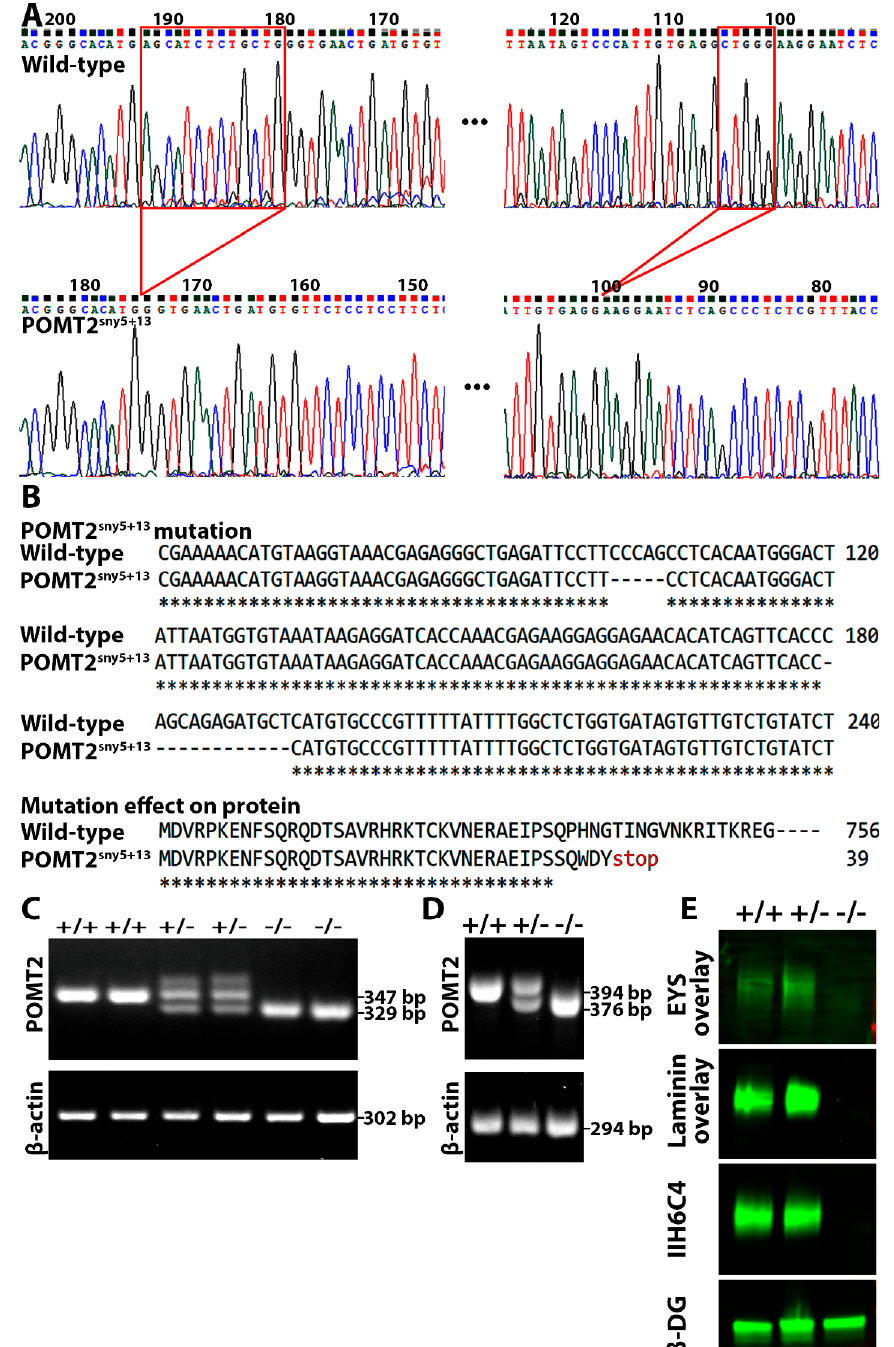
Figure 1. Deletion of pomt2 in zebrafish ablated matriglycan and caused loss of EYS binding. pomt2 mutant zebrafish were generated by CRISPR. Crossing of heterozygous mutant zebrafish generated homozygous mutant fish. Skeletal muscle lysates were used for IIH6C4 immunoblotting and EYS overlay assays. ( A ) Sequencing chromatogram of wild-type and pomt2 sny5+13 PCR product. The two small deletions in exon 2 are bracketed with red marks. ( B ) Alignment of part of exon 2 sequences showing the two small deletions in the pomt2 sny5+13 mutant and alignment of wild-type POMT2 protein with the expected truncated POMT2 peptides in the pomt2 sny5+13 mutant. The mutant POMT2 protein has only 39 amino acid residues in total. ( C ) Example of PCR genotyping showing that wild-type zebrafish produce a 347 bp fragment while homozygous mutant animals produce a 329 bp fragment. ( D ) RT-PCR of wild-type animals produce only a 394 bp fragment, homozygous